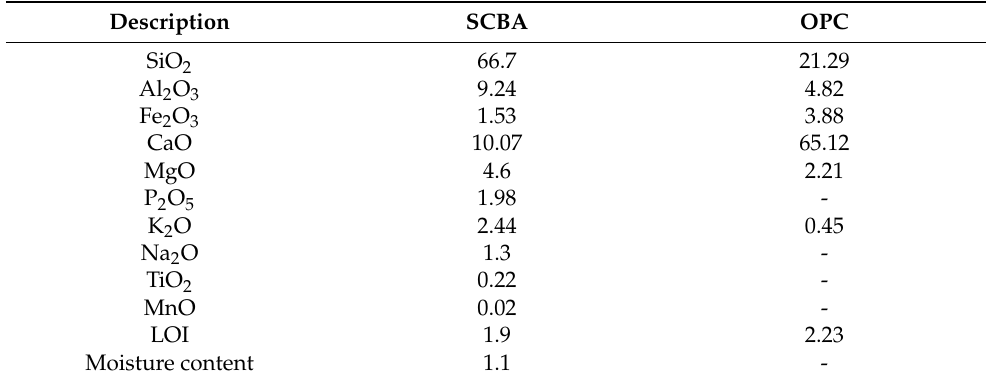
Table 2. Chemical (oxide) composition of sugarcane bagasse ash (SCBA) and OPC. Description